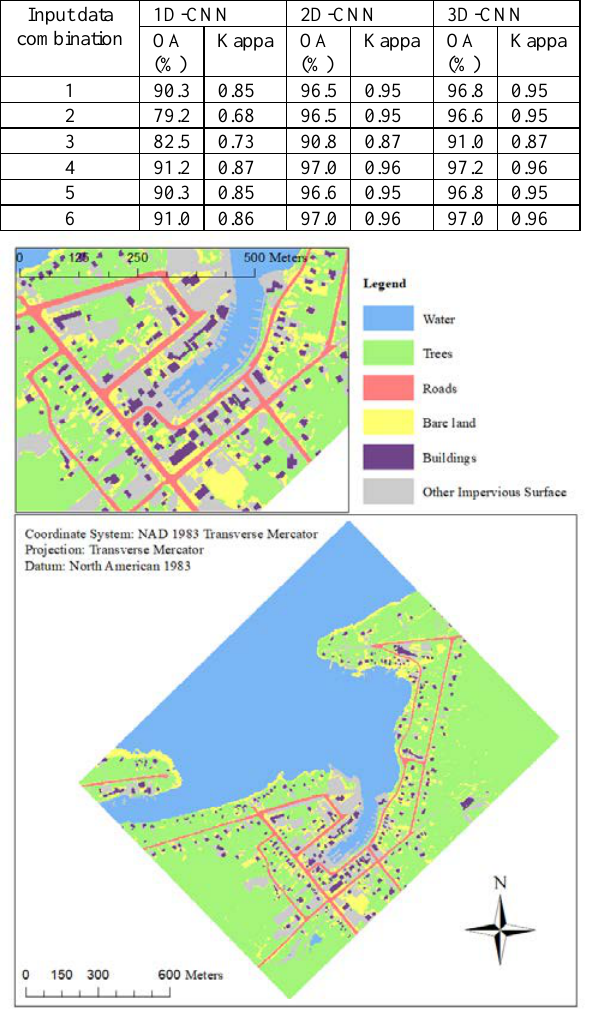
Table 5. Accuracy evaluation.